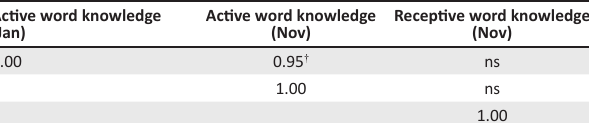
knowledge. Active word knowledge